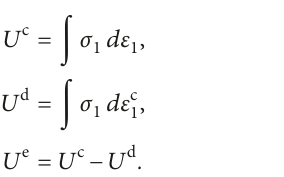
/ ε cp and σ 3 1 1